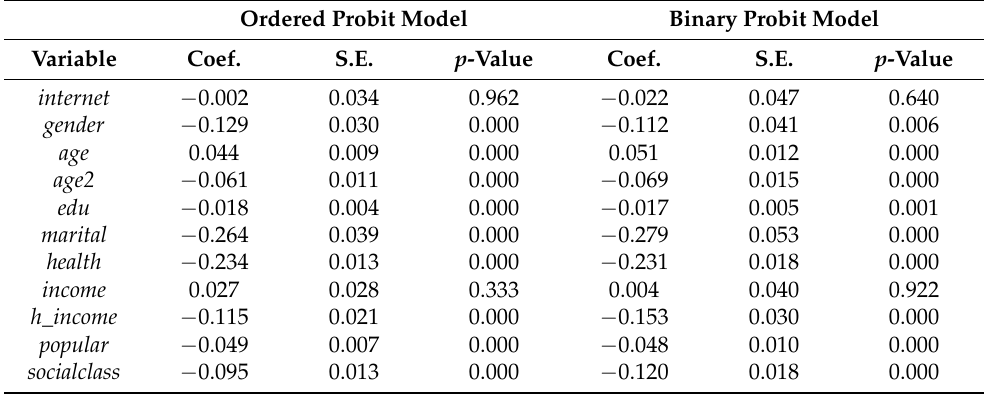
Table 4. Regression results of probit